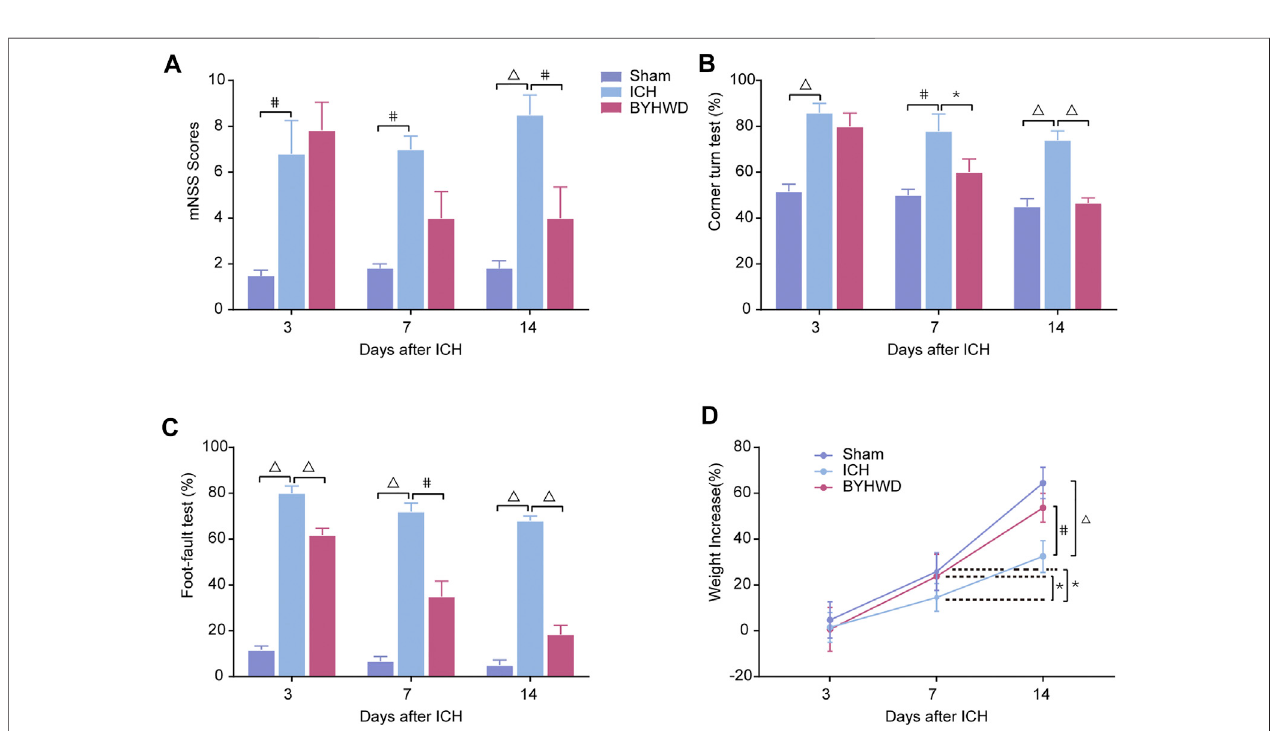
FIGURE1| BYHWDattenuatedneurologicalrecoveryimpairmentafterICH.Onday 3,themNSS (A) ,thecornerturntest (B) ,thefoot-faulttest (C) ,andtheweight increasedrate (D) ofICHandBYHWDgroupweresigni fi cantlydifferentwiththeshamgroup,whichindicatedthesuccessfulICHmodels.Onday14,ratsintheBYHWD group showed a signi fi cantly lower mNSS (A) as well as better performance in corner turn (B) and foot-fault tests (C) and the weight increased rate (D) than the ICH group, which suggested the therapeutic effects of BYHWD for functional recovery after ICH. Data were presented as mean ± SEM ( n (cid:2) 6 each group); * p < 0.05, # p < 0.01, Δ P < 0.001. mNSS, modi fi ed neurological severity score; weight increased, the difference between weight values of days 3, 7, and